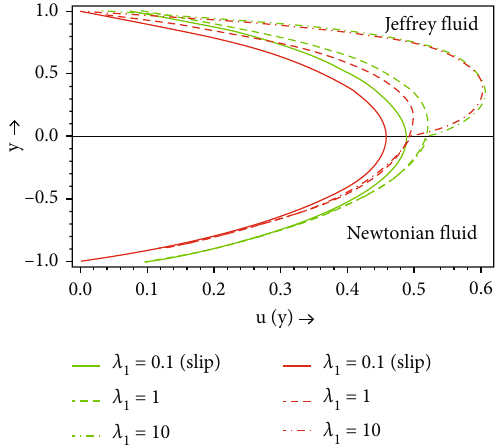
Figure 10: Variation of velocity of Newtonian and Je ff rey fl uids with Je ff rey fl uid parameter λ 1 .